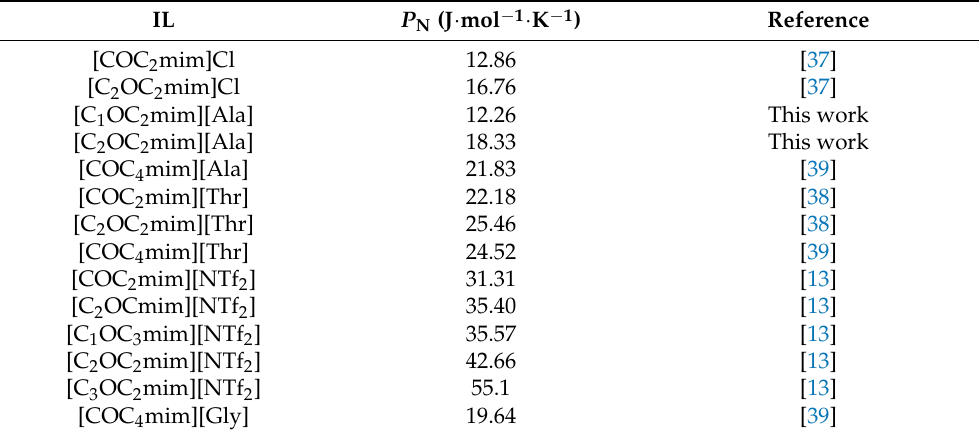
Table 5. Polarity of various ether-functionalized ionic liquids using the new P N scale.